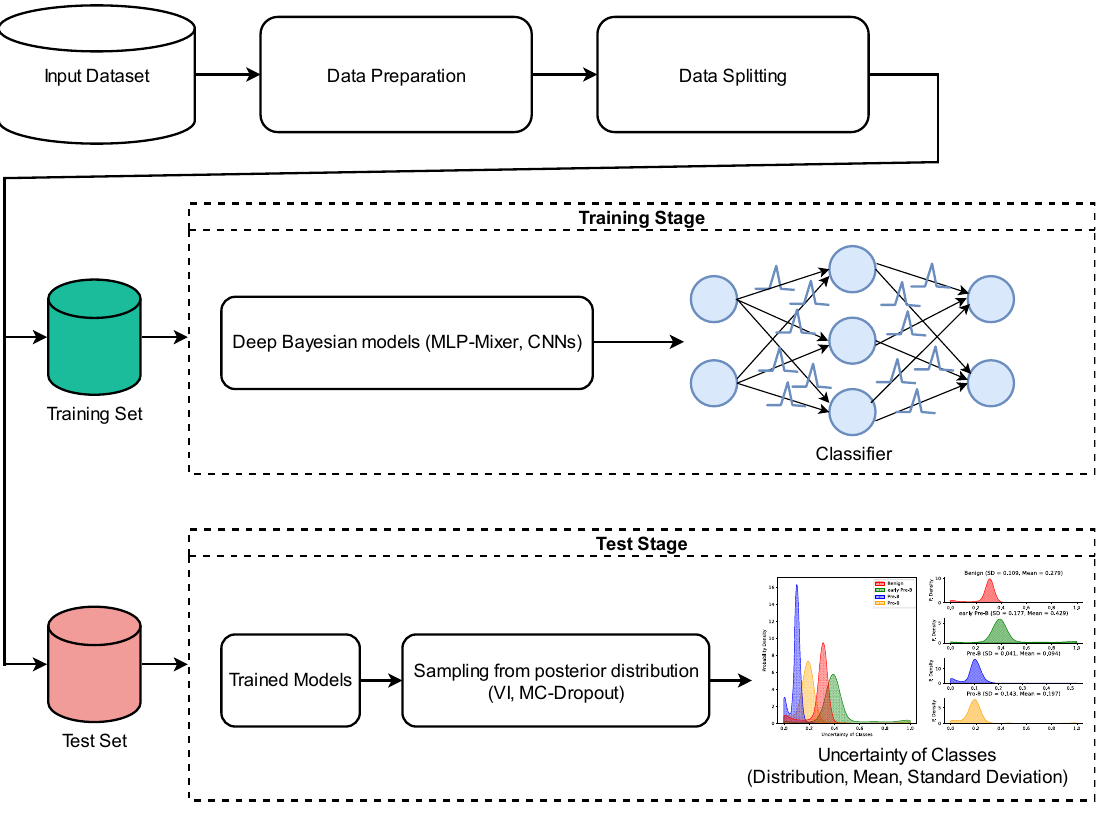
Figure 2. Flowchart of the utilized models and uncertainty quanti fi cation.